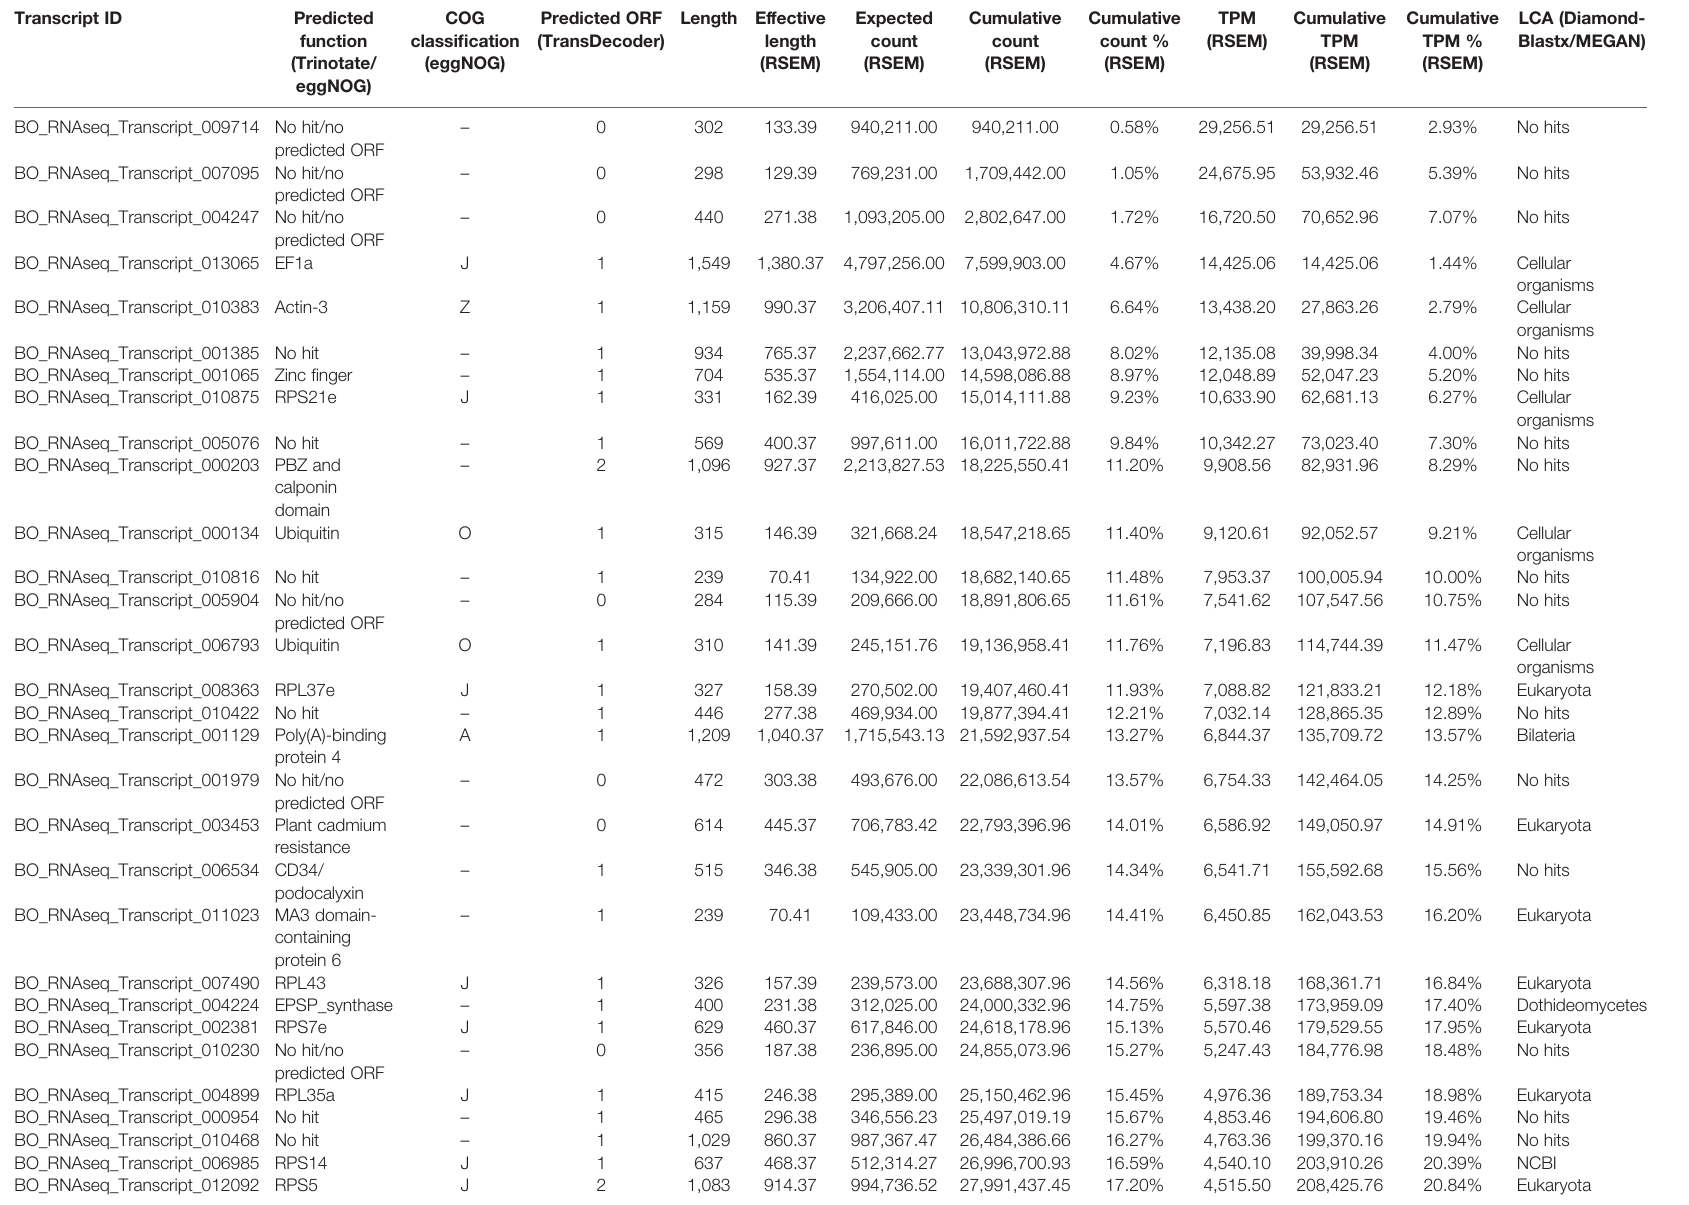
TABLE 2 | Description of the top 30 expressed